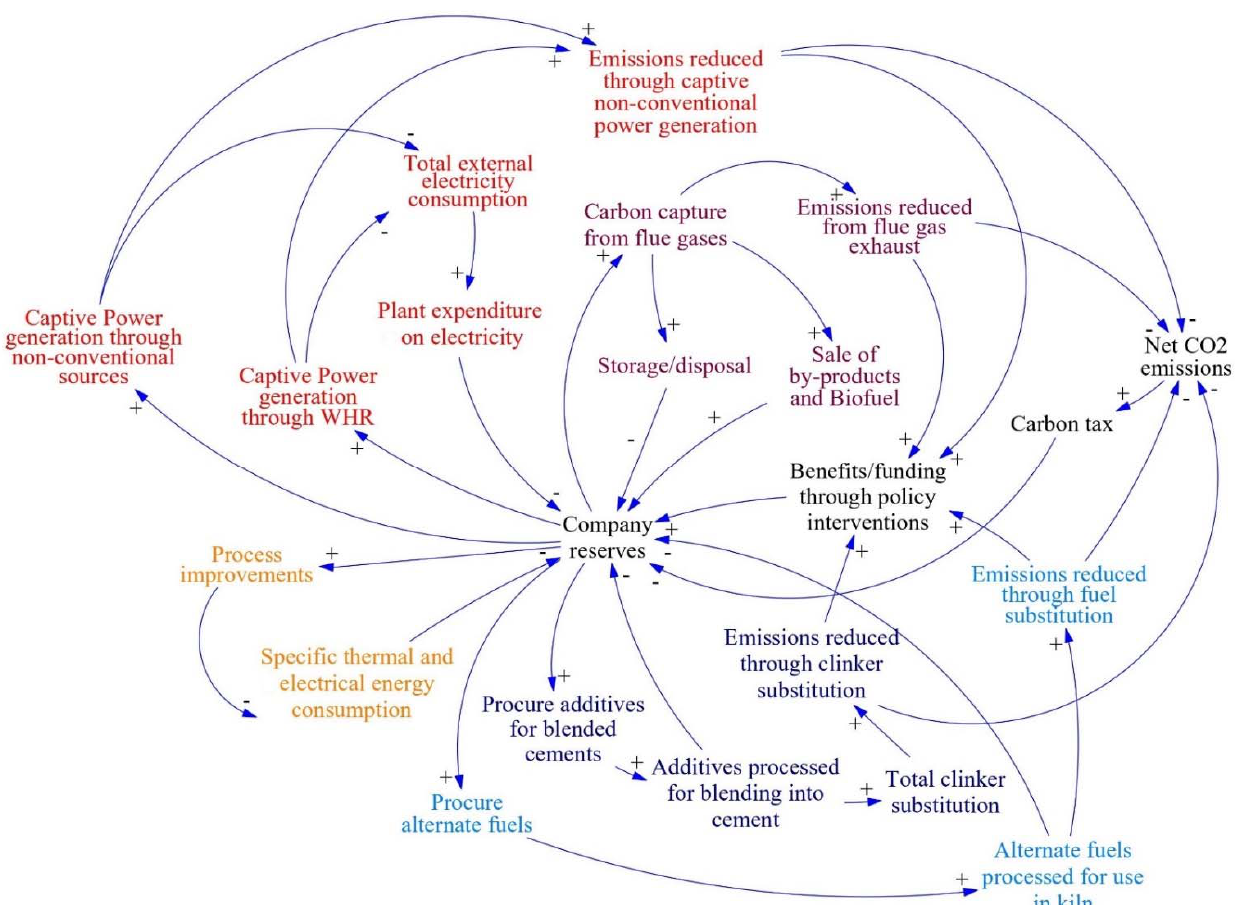
Figure 16. Conceptualisation of the proposed model for the future encompassing all the major mitigation methods currently applicable to a cement plant. The colours indicate the grouping of elements as per the mitigation strategy; red—captive power generation, orange—efficiency improvements, purple—carbon capture, teal—fuel substitution and indigo —clinker substitution.